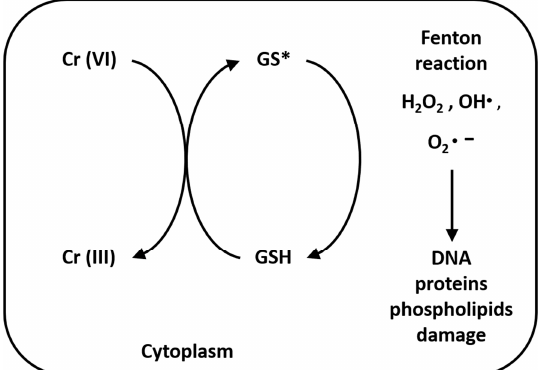
Figure 2. Reduction reaction of Cr(VI) to Cr(III) and Fenton reaction. The reaction process of Cr(VI) to Cr(III), especially in the presence of GSH, produces hydrogen peroxide (H 2 O 2 ), hydroxyl radicals ( • OH) and superoxide anion radicals (O 2• ), due to Fenton reaction. These ions are very unstable, causing lipid peroxidation, DNA and protein damage [37]. 3. Bioavailability, Absorption and Excretion of Cr(III) and Cr(VI) Brewer’s yeast, sea food, oysters, liver, meat, cheese, fruits, green beans, spinach and broccoli are dietary sources rich in Cr(III) (Table 3). Chromium content in food is influ-